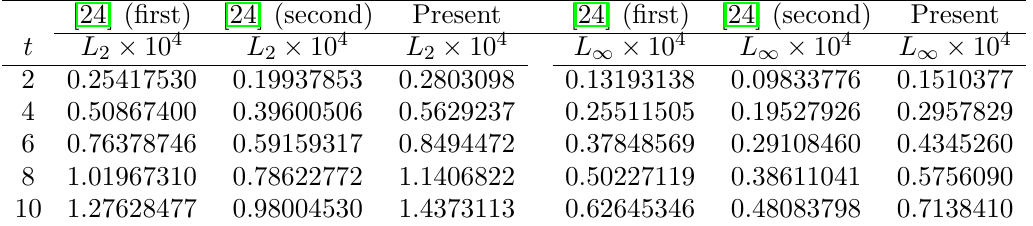
Table 6. Invariants and their comparison on 0 ≤ x ≤ 100 for N = 250, ∆ t = 0 . 01, µ = 1 ,p = 4, c = 0 . 3